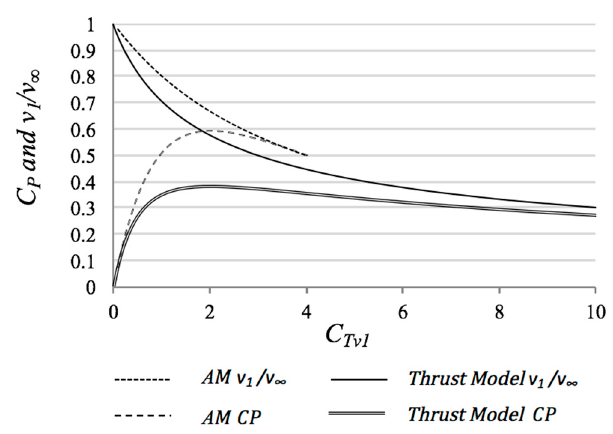
Figure A5. General AM and Thrust Model predictions of v1 and C P vs. C Tv 1 in a tube ( β = 1).